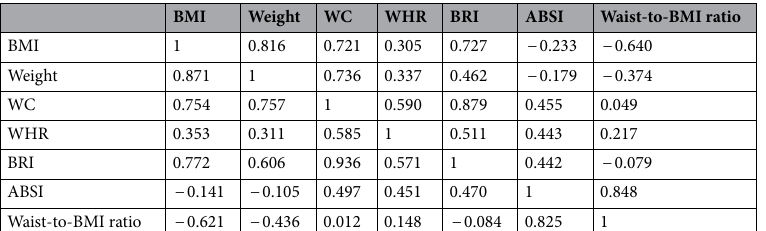
Table 2. Correlations between BMI and various anthropometric indices. Right side (above diagonal) shows correlations of the raw values; left side (below diagonal) shows correlations of the z scores relative to age- and sex-specific means. ABSI A body shape index, BMI Body mass index, BRI Body roundness index, WC Waist circumference, WHR Waist-hip ratio.